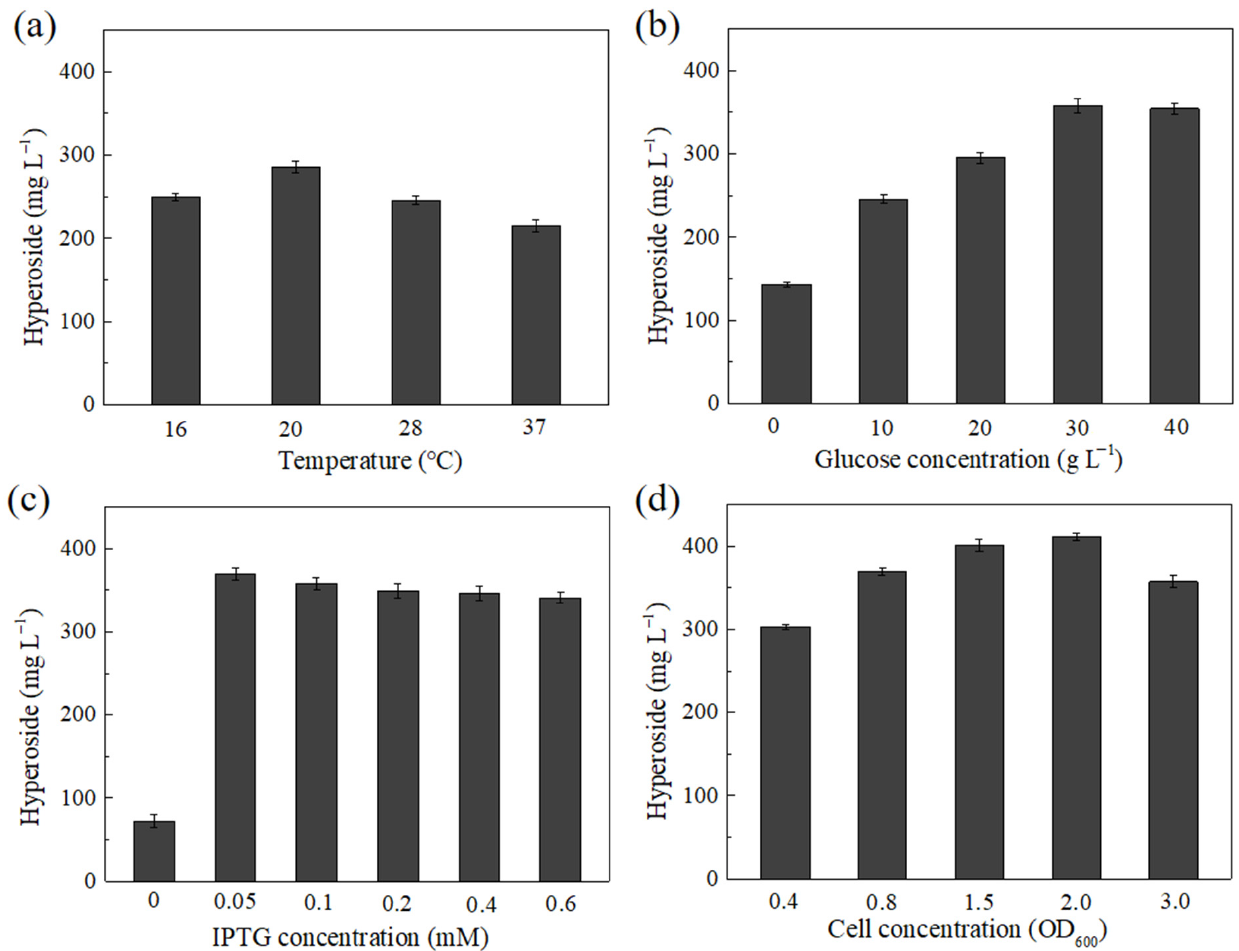
Figure 5. Optimization of hyperoside fermentation conditions using recombinant strain BL21-V. ( a ) The effects of the induction temperature on hyperoside production. ( b ) The effects of the glucose concentration on hyperoside production. ( c ) The effects of the IPTG concentration on hyperoside production. ( d ) The effects of the cell concentration on hyperoside production.